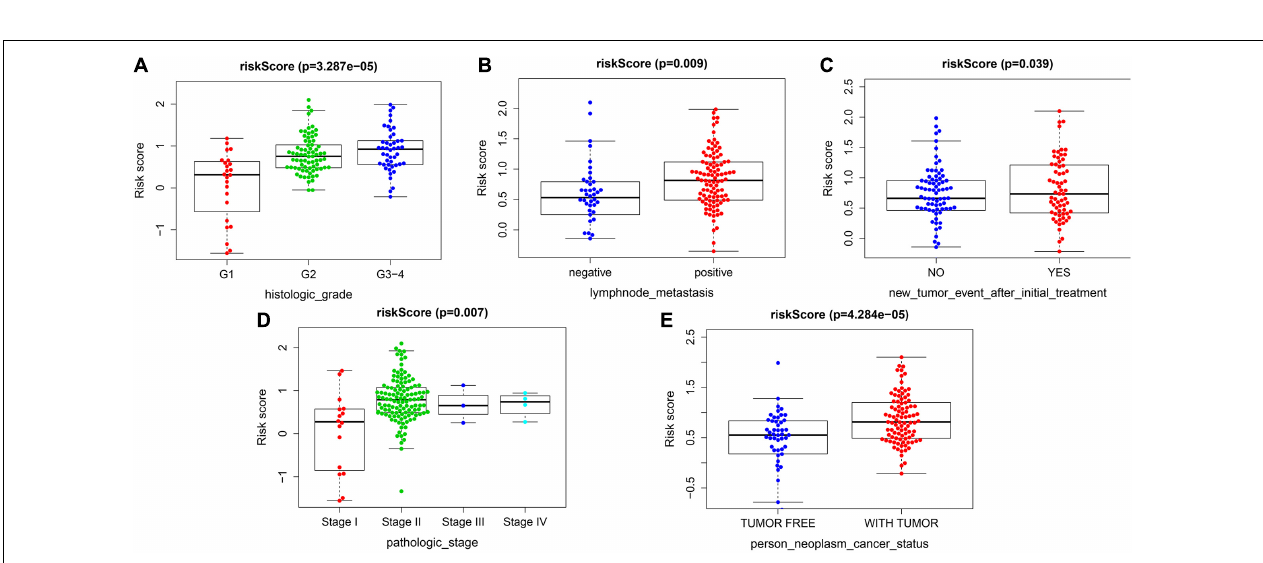
FIGURE 6 | Correlation analysis between risk score and clinicopathological characteristics. (A) Histopathological grade. (B) Lymph node metastasis. (C) New tumor event after initiate treatment. (D) Pathological stage. (E) Individual neoplasm status.